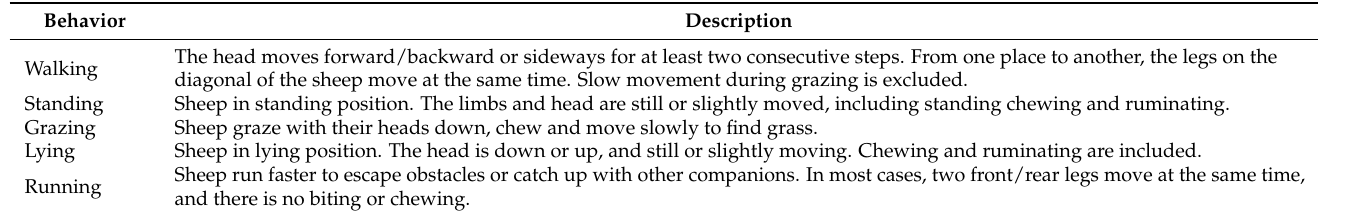
Table 2. Definition of the five behaviors for classification. Definition adapted from [3,9,17,22,24]. Behavior Description Walking